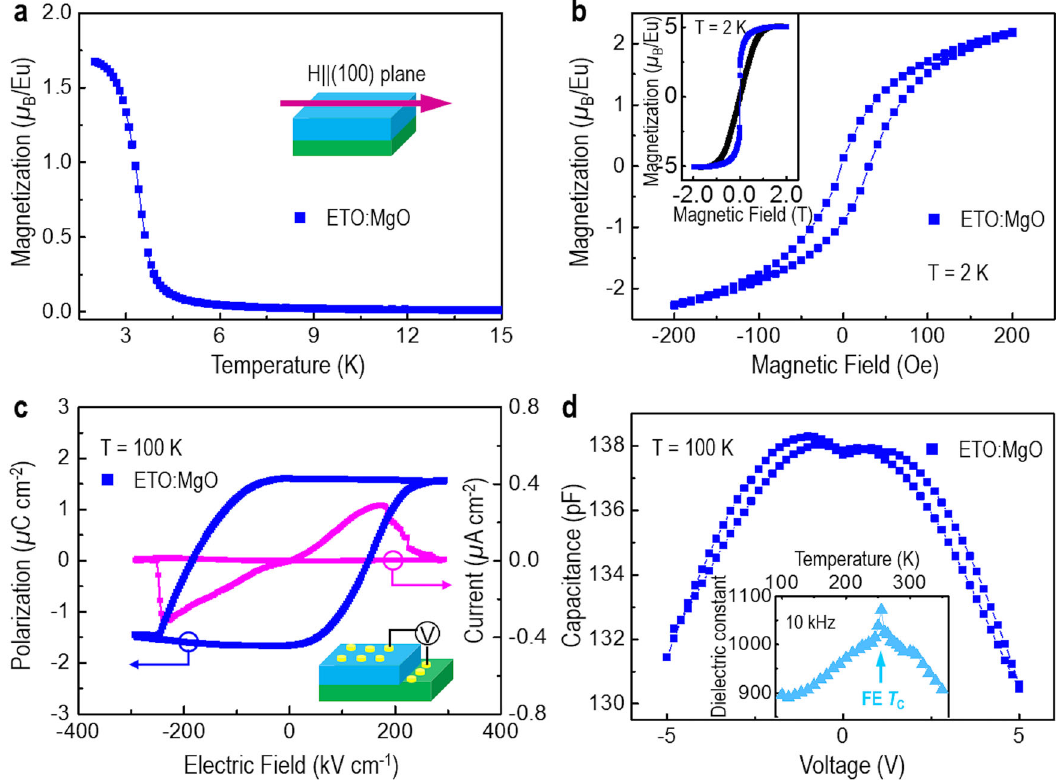
Fig. 3 Multiferroic properties of an ETO:MgO VAN fi lm. a Temperature and ( b ) magnetic fi eld-dependent magnetization measured by applying a magnetic fi eld along the IP direction. The inset of ( b ) shows the comparison of magnetic hysteresis loops measured by applying a magnetic fi eld along the IP (blue) and OOP (black) directions. c Ferroelectric polarization hysteresis loop and switching current measured by PUND and at 1 kHz. d Capacitance – voltage curve measured at 100 K. The inset shows the temperature-dependent dielectric constant showing a FE T C of ∼ 255 Multiferroic properties of an ETO:MgO VAN fi lm . The mag- around 5.1 K (Supplementary Fig. 8b), close to magnetic ordering netic properties of 300 nm thick VAN and 300 nm thick plain temperature ( T N ~ 5.3 K) for bulk ETO 12,13 . In contrast, the fi lms are compared in magnetization versus temperature ( M – T ) magnetization ( M) of the VAN fi lm increases monotonically with decreasing temperature and almost saturates at 2 K (Fig. 3a). and magnetic fi eld ( M – H ) plots in Fig. 3a, b and Supplementary Furthermore, a clear magnetic hysteresis loop with a coercivity Fig. 8. The plain ETO fi lm displays a distinct AFM transition